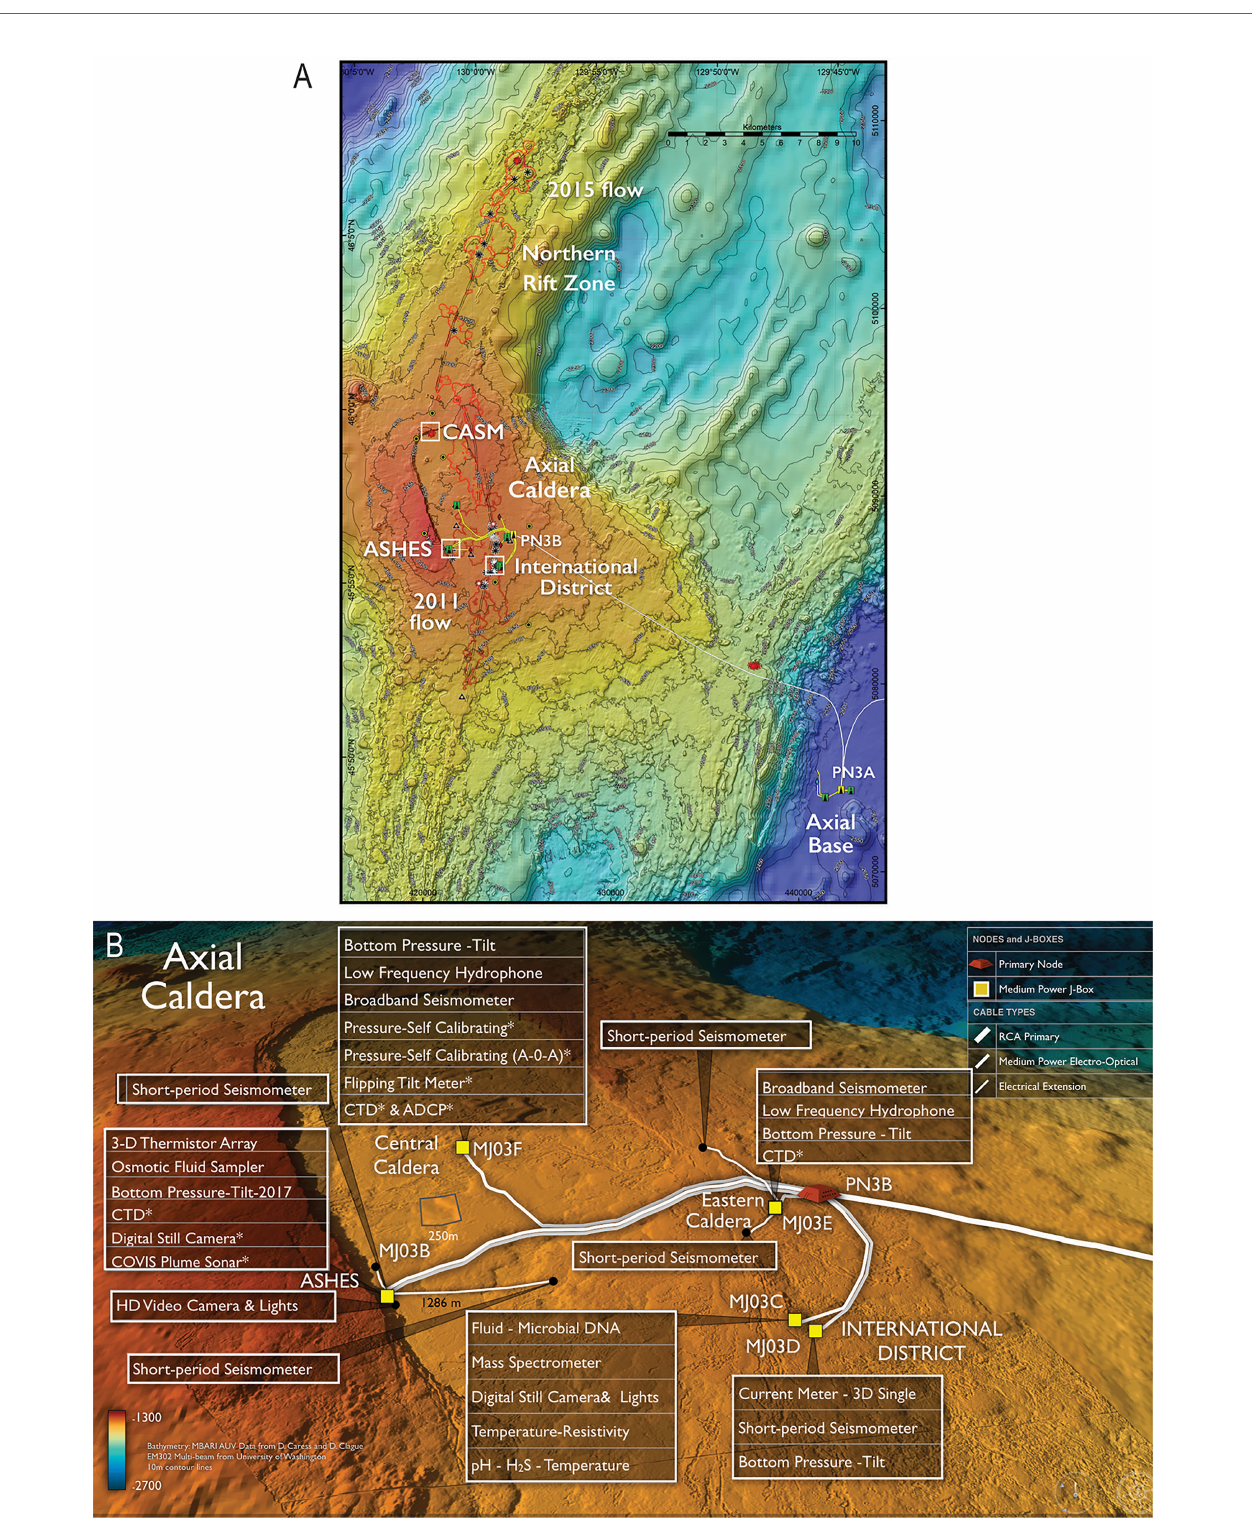
FIGURE 4 | The Ocean Observatory Initiative Axial Seamount array on the Juan de Fuca Ridge. (A) Regional bathymetry showing the main hydrothermal vent fi elds. (B) Details of the instruments locations within the axial caldera. * indicate instruments funded outside of OOI.